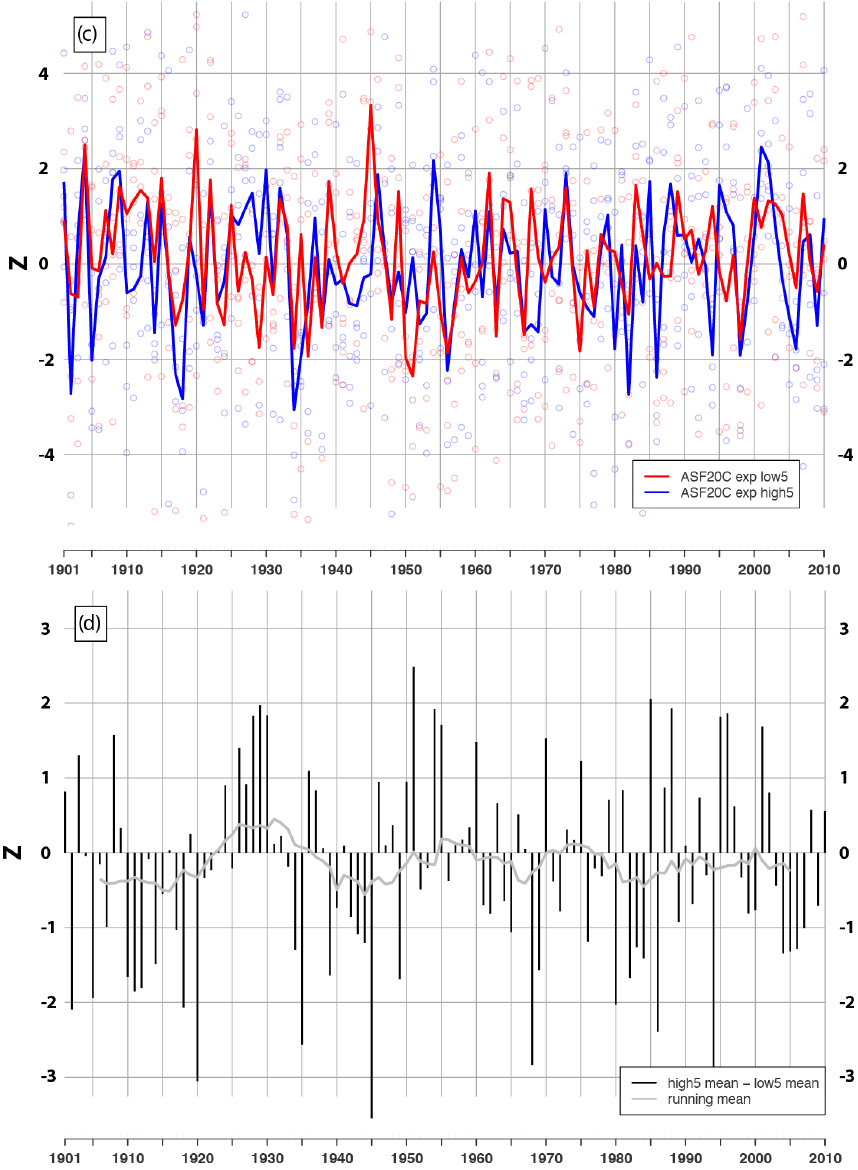
Figure 1. (a) Normalized 1 November Eurasian snow dipole index for the period 1900–2010 as derived from ERA20C. (b) Normalized DJF NAO index in the CRU station-based reconstruction, ERA20C EOF-based index, ASF-20C CTL and ASF-20C EXP EOF-based index. Hollow points represent individual members; solid lines represent ensemble means or observational products. (c) Five-member DJF NAO forecasts for the high- and low-dipole members within ASF-20C EXP. Hollow points represent individual members; solid lines represent ensemble means. (d) NAO DJF state difference and its 11-year running mean between the ASF-20C EXP high- and low-dipole ensemble mean in panel (b) (51 (18) cases of positive ( + 1SD) NAO response; 59 (29) cases of negative ( − 1SD) NAO response). For 2SD exceedance, the number of cases is 2 vs.